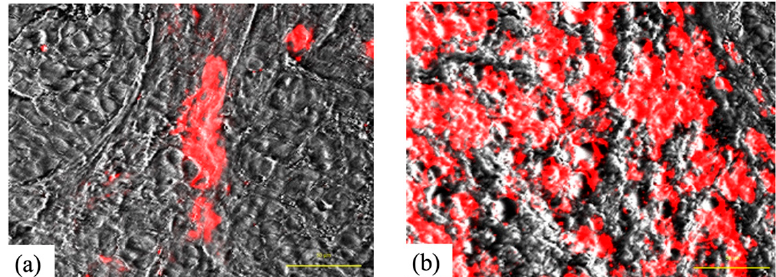
Figure 11. Intratumoral localization of glucose-conjugated chlorin e6 in SNP tumors 5 min and 3 h after administration. ( a ) Glucose-conjugated chlorin e6 (G-Ce6) fluorescence was observed within the tumor blood vessel 5 min after administration. ( b ) G-Ce6 fluorescence was apparent in both tumor interstitial tissue and tumor cells 3 h following administration. Scale bar, 50 µ